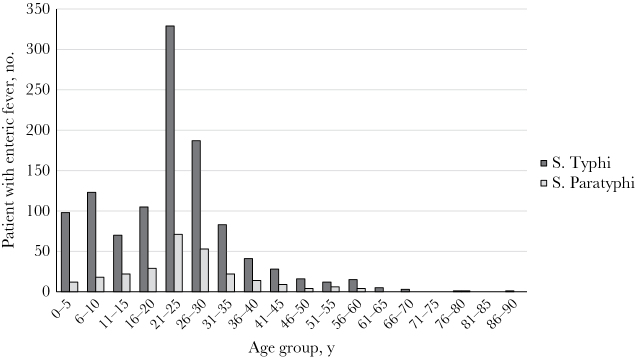
Age distribution, by 5-year age group, among 1382 patients with laboratory-confirmed enteric fever, by organism, all hospital sites, India, 2014–2015. : S. Paratyphi, Salmonella enterica subspecies enterica serovar Paratyphi; S. Typhi, Salmonella enterica subspecies enterica serovar Typhi.